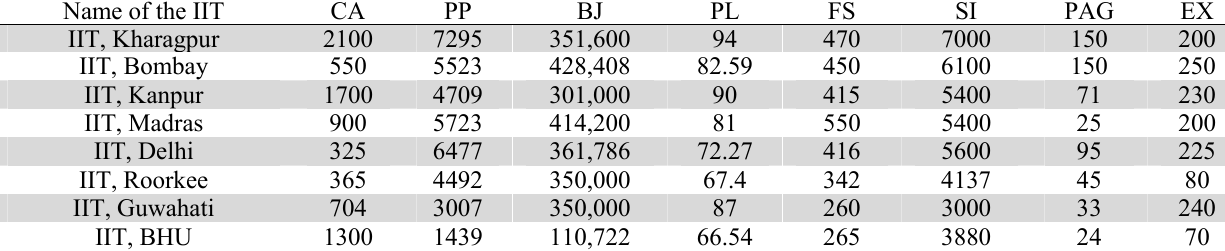
Normalized decision matrix